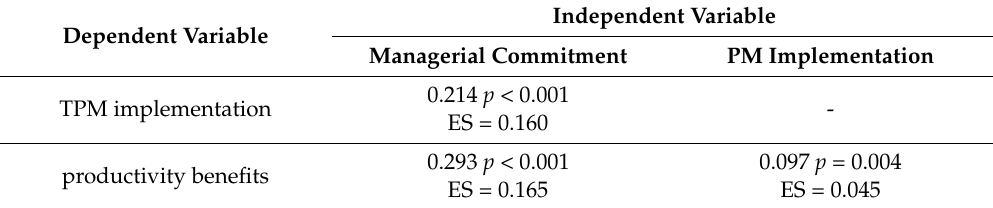
Table 7. Indirect